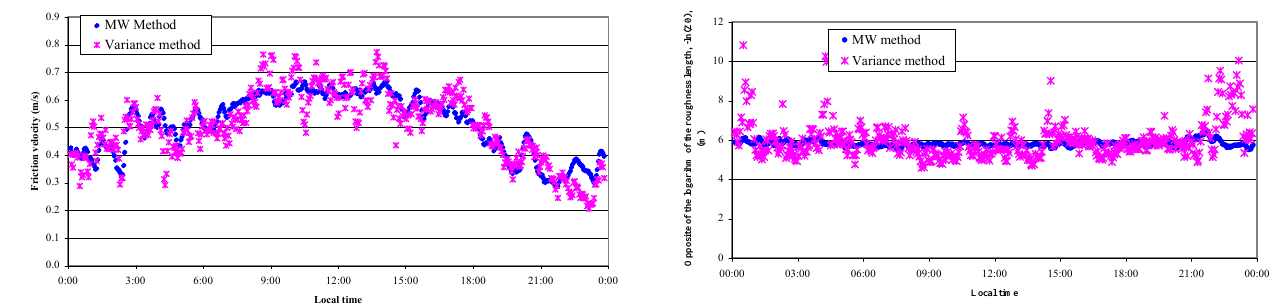
Fig. 8b. Roughness length. Comparison between the statistical Figure 8.b: Roughness length. Comparison between the statistical method MW and the variance method (Plot RT, 25 July 1997) method MW and the variance method (Plot RT, 25 July 1997).